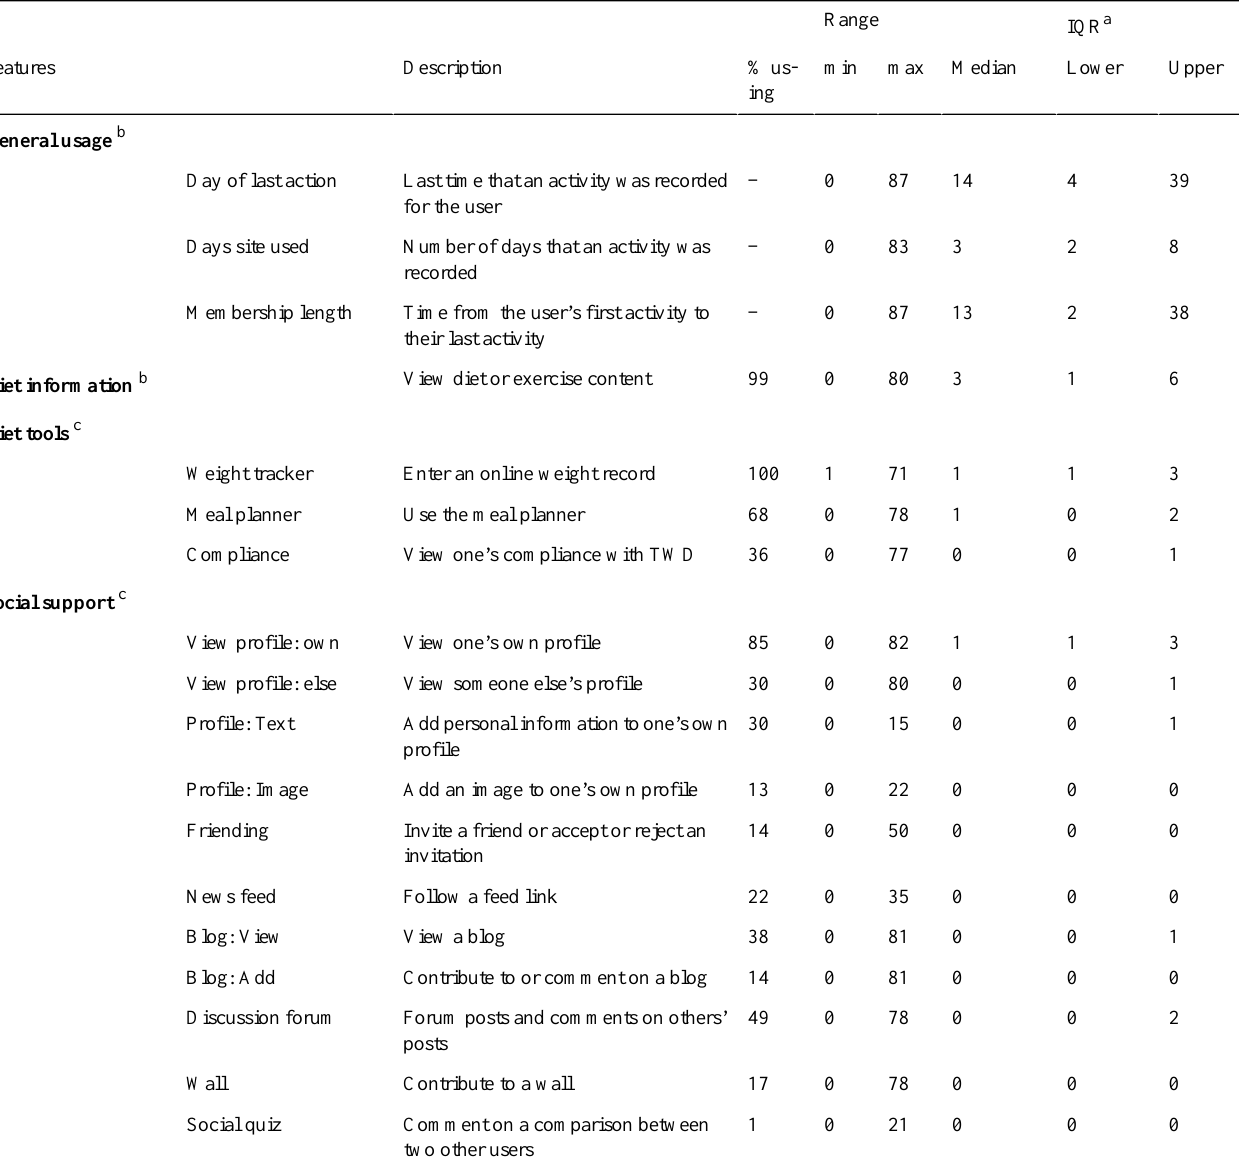
Table 3. Website features and uptakes for starters (n =